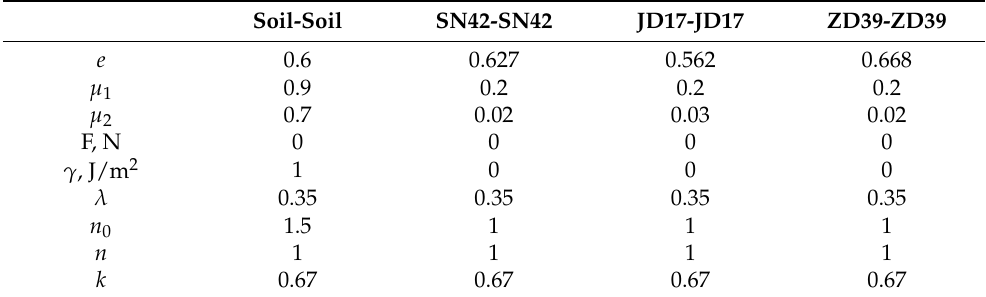
Figure 3. Angle of repose of piling test. 3.2. Screening of Sensitive Parameters Taking JD17 as the research subject, the sensitive parameters were screened by means of a PB test. For the simulations, according to the previous study, the soybean seed particle model was 13-sphere model [16], the soil particle model had a particle size of 1 mm and was generated from a uniform distribution of 3-sphere and spherical parti- cle models. The material parameters were determined in previous studies [16–18]. Dur- ing the simulation, soil particles and soybean seed particles were first generated. After both the soil particles and soybean seed particles had settled, a vertical velocity of 1 m/s